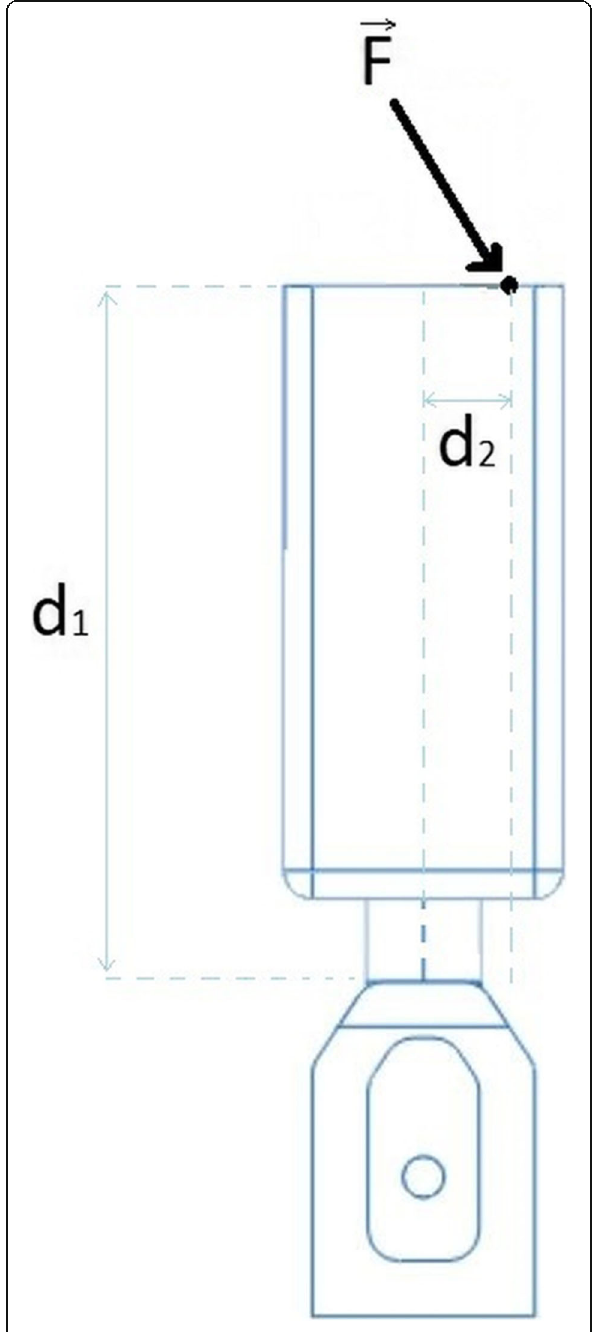
Fig. 12 Schematic diagram of the reference model with the representation of the applied force and the distances d1 and d2 responsible for the bending moments on the bone and, therefore, the generation of high stresses at the margin bone